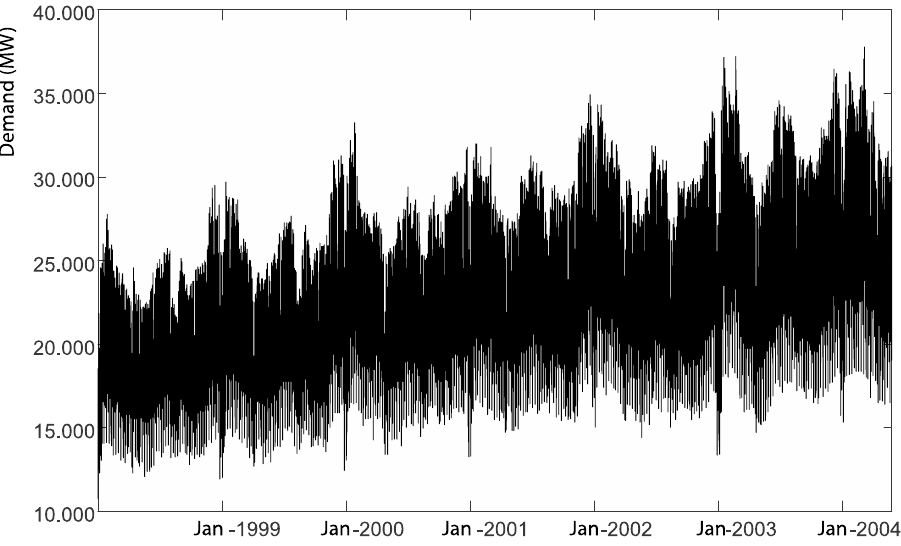
Figure 1. Spanish hourly electricity demand in the period 1998 to 2004.